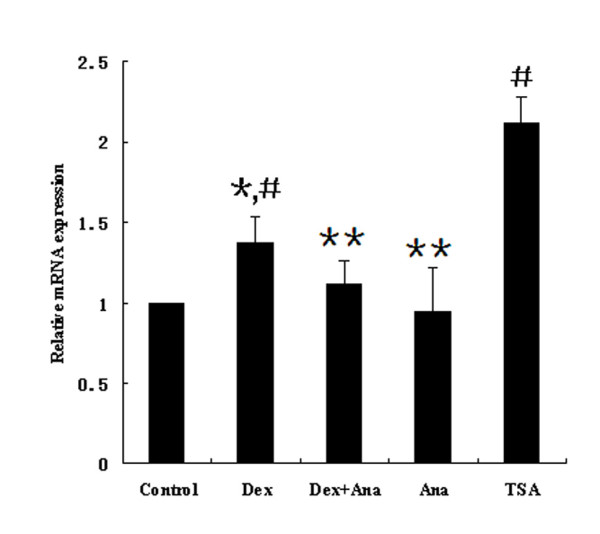
Effect of anacardic acid, dexamethasone and TSA on PTEN expression in A549 cells. Cells were incubated with dexamethasone (10-5 M), the HAT inhibitor anacardic acid (20 μmol/L) plus dexamethasone (10-5 M), anacardic acid (20 μmol/L) or TSA(1 μmol/L) for 24 h. The PTEN mRNA level was measured by quantitative real-time PCR. A representative of three separate experiments is shown. #p = 0.006 vs control group; *#p = 0.0469 vs Dex+Ana group; **p > 0.05 vs control group.